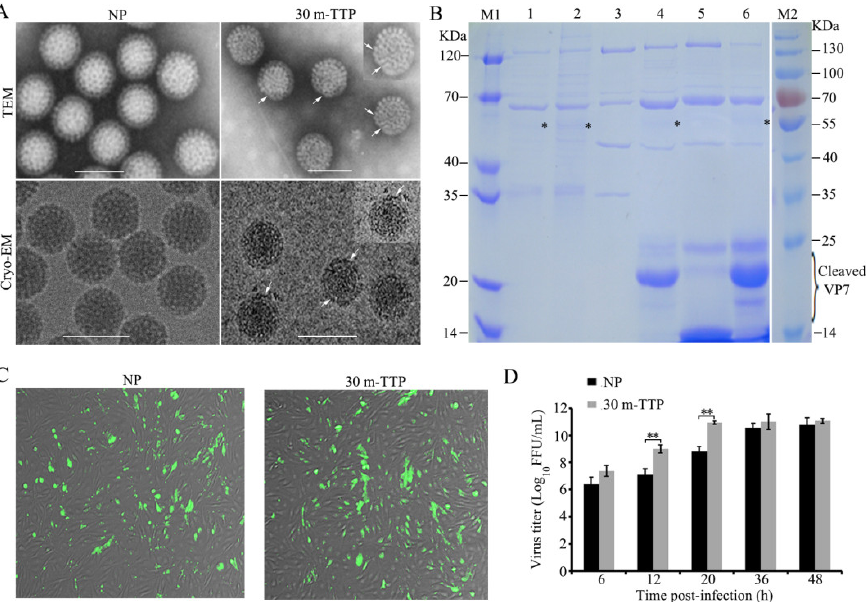
Figure 6. Analyses of early cleavage particle component of GCRV with limited tryptic digestion. ( A ) TEM and cryo-EM of NP and 30m-TTP of GCRV. Arrowheads indicate degraded outer shell protein subunits of 30m-TTP. The 30m-TTP was generated from purified NP preparations of GCRV (~1.5 µ g/mL) by treating with trypsin (final concentration: ~100 mg/mL) at 28 ◦ C for 30 min, and then the treated and un-treated preparations were directly applied to a quantifoil grid for TEM, cryo-EM, and inoculation on CIK cells for infectious assays without conducting further purification. ( B ) GCRV particle with limited tryptic-digestion was resolved using SDS-PAGE. M1 and M2, different standard protein marker; 1–2, top component/empty particle; 3, NP of GCRV; 4, 15m-TTP; 5, 30m-ChTP; 6, 30m-TTP; * indicates a VP5C/ δ fragment. ( C , D ) Infectivity assays with 30m-TTP and NP of GCRV: CIK cells were infected with 30m-TTP and NP of GCRV, respectively. At 6 h p.i., cells were fixed and stained with anti-VP5 antibody and Alexa-488-labeled donkey anti-mouse IgG to visualize viral replication. Representative images of a fluorescent focus unit assay ( C ). Viral titers were determined at different infection time points ( D ). Data shown are the mean ± standard deviation of three individual experiments. Statistical significance is indicated by asterisks (**, p < 0.01). GCRV, grass carp